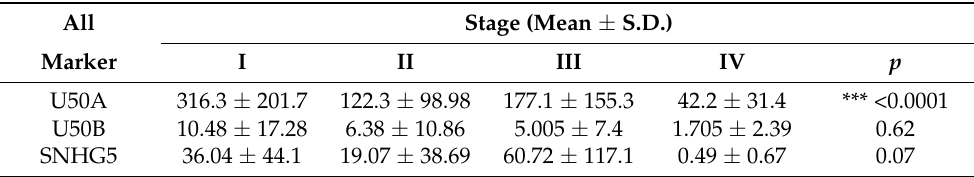
Table 3. Correlation between copy numbers of U50A, U50B, or SNHG5 with pathological stages of breast cancer